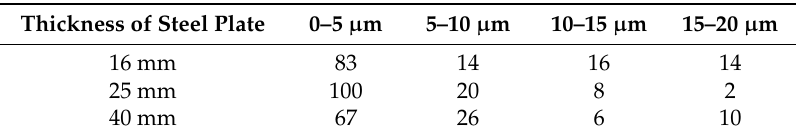
Table 4. Statistical result of micro-inclusions in different HAZ.